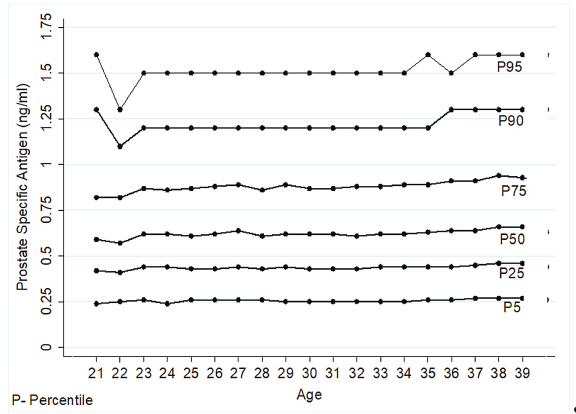
Figure 5 - PSA percentiles values according